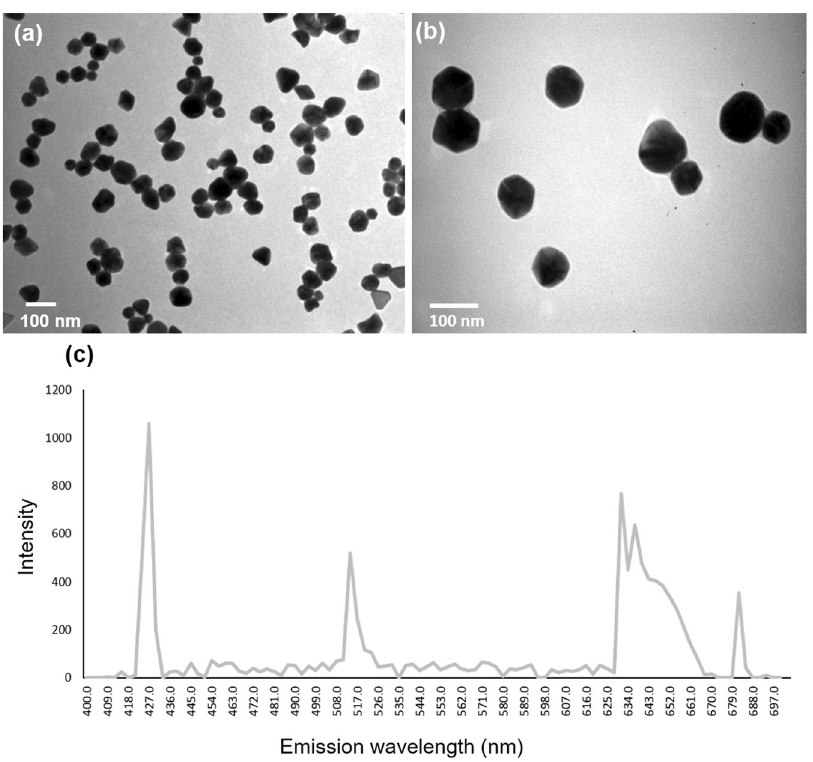
Figure 1. TEM image of AgNPs using different magnifications. ( a ) Bar = 100 nm, ( b ) Bar = 100 nm and ( c ) Fluorescence by multiphoton